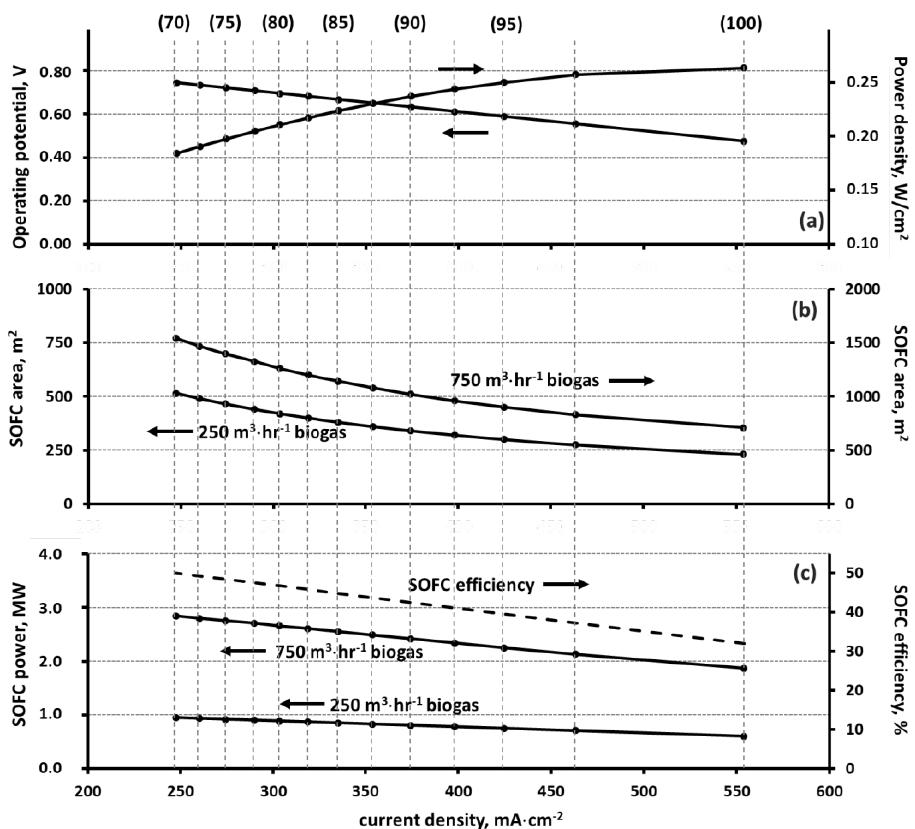
Figure 2. SOFC size and operation characteristics: ( a ) SOFC operation potential and power density (values in parentheses denote power density as percentage of the SOFC’s maximum power density), ( b ) SOFC’s surface area, and ( c ) SOFC efficiency and total power generation, for the two examined scales of the integrated plant.